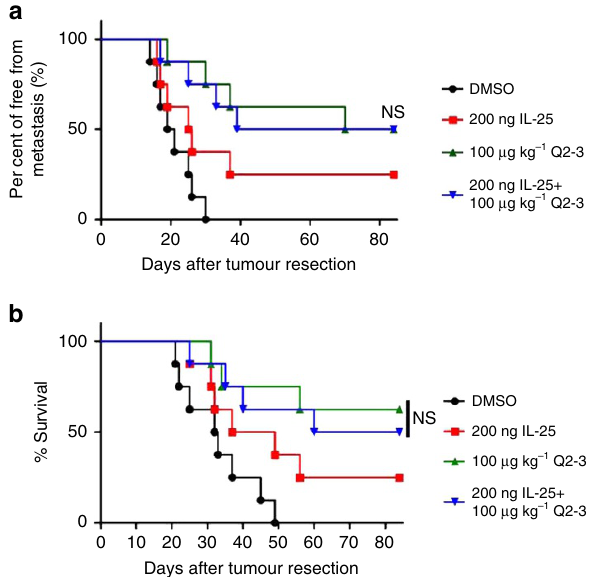
Figure 6 | In vivo treatment of Q2-3 confers comparable anti-metastatic activity with IL-25 administration. ( a ) Tumour-resected mice ( n ¼ 8 per group) were treated with PBS (0.1% DMSO in saline), IL-25 (200ng per mice), Q2-3 (100 m gkg (cid:2) 1 ) or co-treated with IL-25 and Q2-3 for 3 weeks. Quantification of tumour metastasis by measuring luciferase activity in photonss (cid:2) 1 cm (cid:2) 2 sr (cid:2) 1 in mice revealed along the indicated time course. ( b ) Survival of test mice after different treatments. NS, no significant difference between the Q2-3 and co-treatment groups (Kaplan–Meier results were analysed by log-rank test). Similar results were obtained from three independent